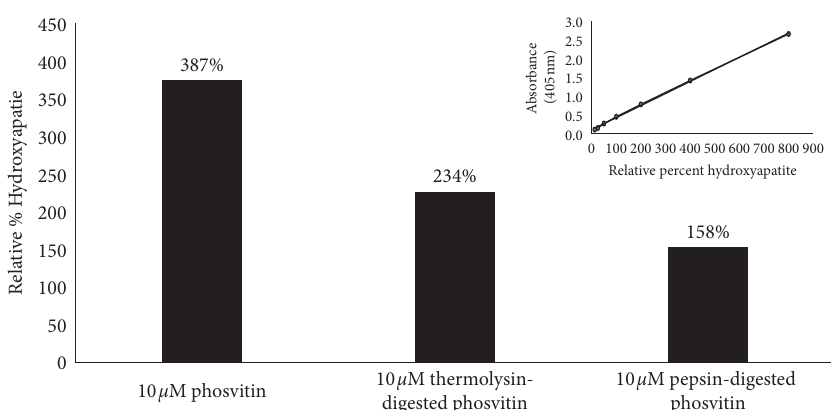
Figure 1: Extent of formation of calcium phosphate pellets in the presence of phosvitin. A calcium phosphate pellet assay was used to determine the effect of phosvitin or phosvitin digests on the extent of pellet formation. The amount of calcium retained in the pellet was determined using the alizarin red